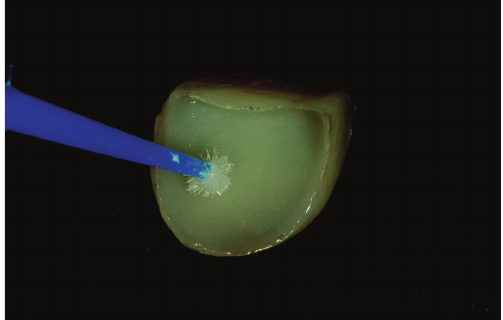
Figure 8: Cervical margins of the preparations exposed with gingival retractor cord.